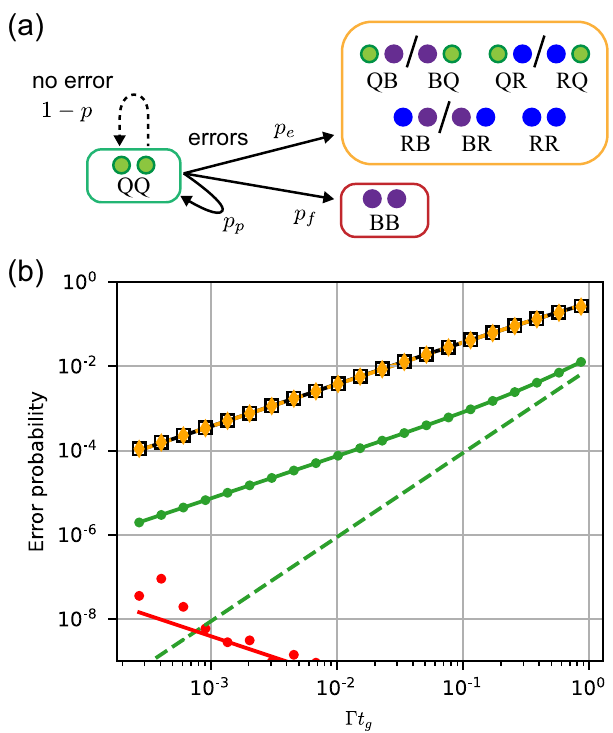
Fig.2| Gateerrormodelandsimulatedperformance.a Possibleatomicstatesat the end of a two-qubit gate. The con fi gurations grouped in the yellow box are detectable erasure errors; red, undetectable errors; and green, the computational space. b Gate error asa function ofthe gateduration t g . The averagegate in fi delity 1 (cid:3) F (black squares) is dominated by detectable erasures with probability p e (orange points). The in fi delity conditioned on not detecting an erasure, 1 (cid:3) F (cid:1) e (green points) is about 50 times smaller. This re fl ects decays to Q with probability p p , and a no-jump evolution contribution (green dashedline).The probability p f of undetectable leakage (red points) is very small. The lines are analytic estimates of each quantity, while the symbols are numerical simulations. Both assume V rr / Γ =10 6 , and Ω is varied along the horizontal